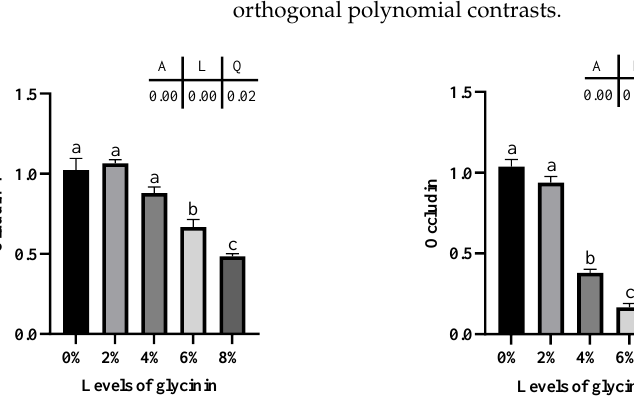
Figure 5. Protein metabolism enzyme activities in liver of hybrid yellow catfish fed with different glycinin levels. Data describe mean ± SE (n = 3). Obvious difference of means between groups is indicated by a, b and c ( p < 0.05). A represent the variance analyzed by one-way ANOVA; L represent linear trend analyzed by orthogonal polynomial contrasts; Q represent quadratic trend analyzed by orthogonal polynomial contrasts.